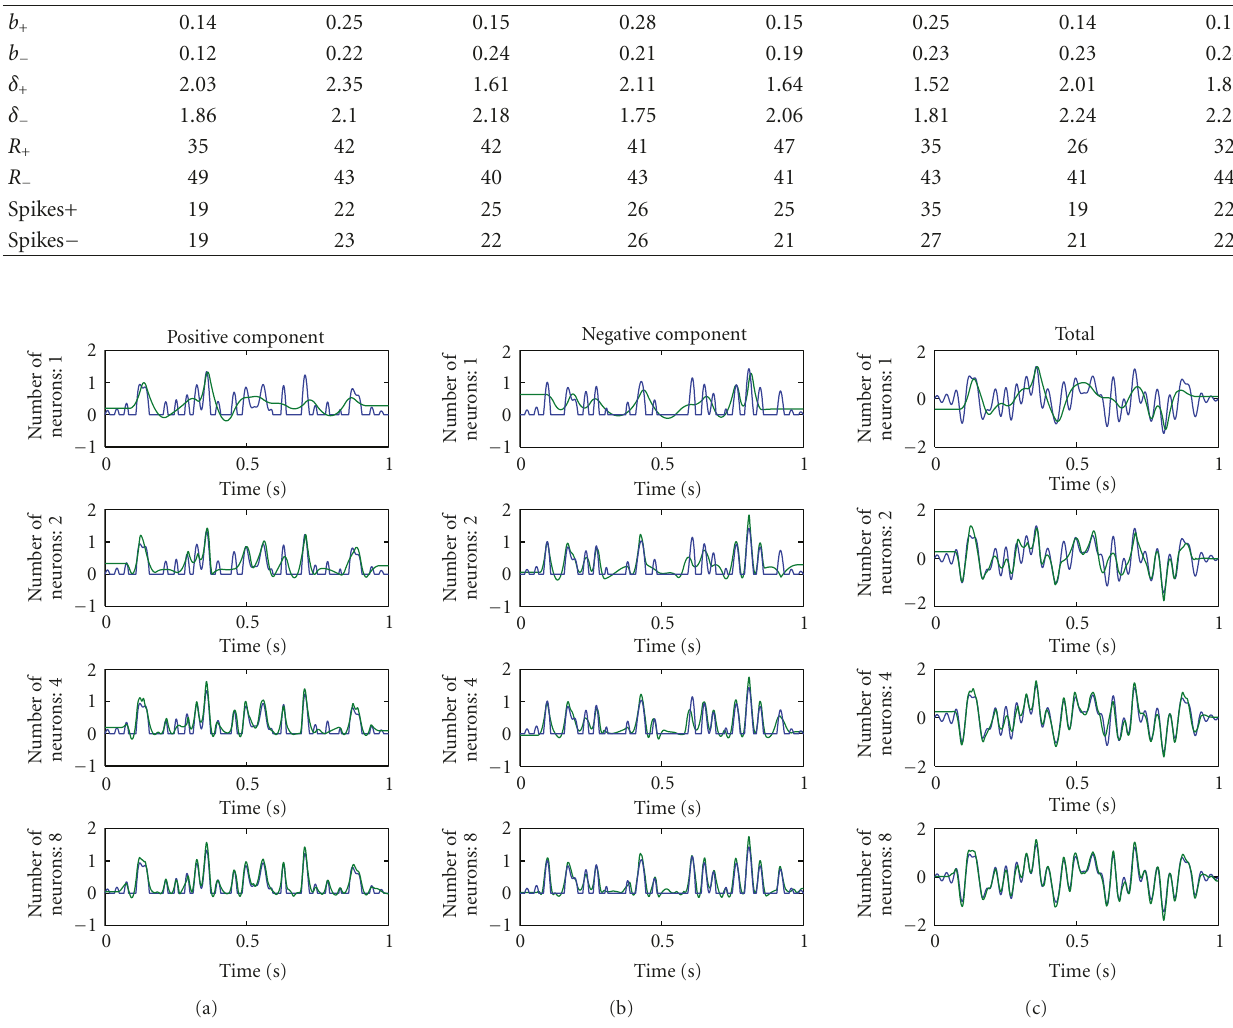
components, and the total stimulus, respectively. The four rows show the recovery when 1, 2, 4, and 8 encoding neurons are, respectively, used. Blue lines correspond to the original stimuli and green to the recovered ones. It can be seen that the recovery improves when more neurons are used. This can also be seen from Figure 8 where the corresponding mean value SNRs are plotted. The error bars in the same figure correspond to the standard deviation of the associated